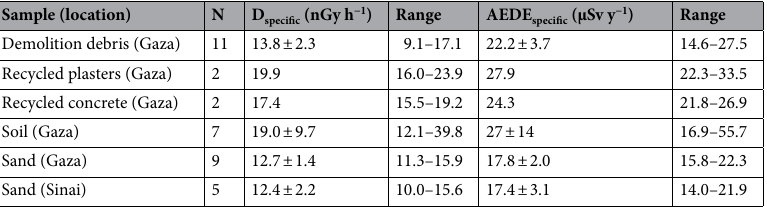
Table 6. Specific absorbed dose rate and the corresponding AEDE in air of the crushers calculated for each material of pile (mean ± standard deviation), n: number of